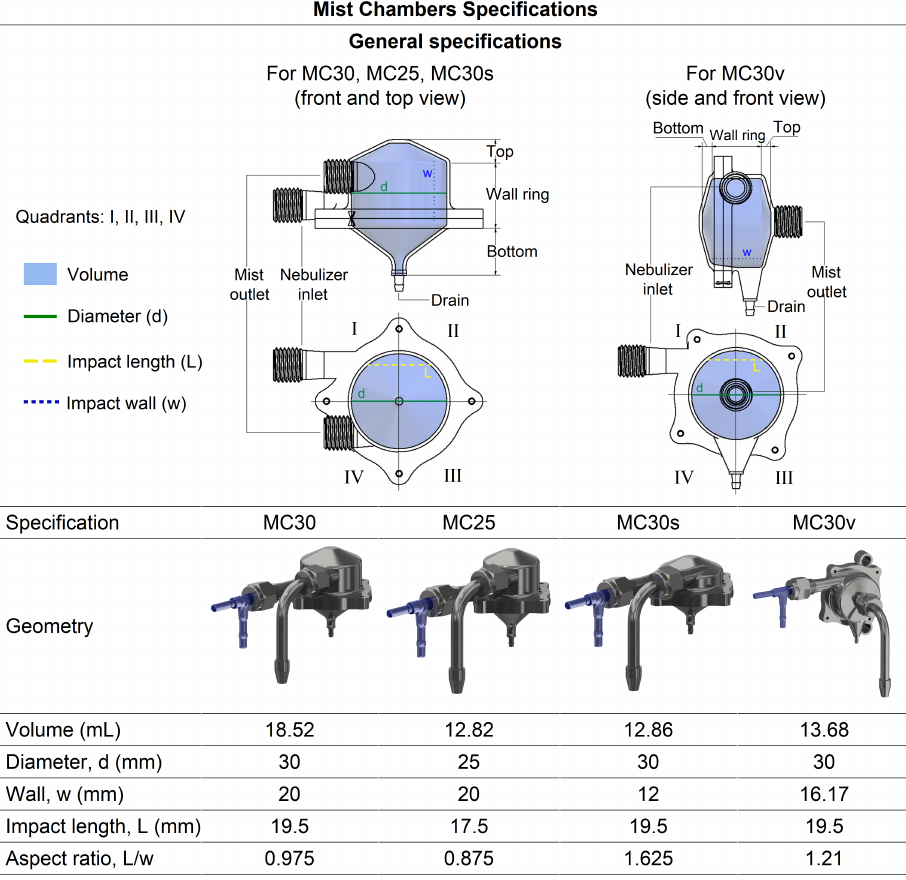
Figure 4. Drawings and specifications of the different mist chamber designs used in this